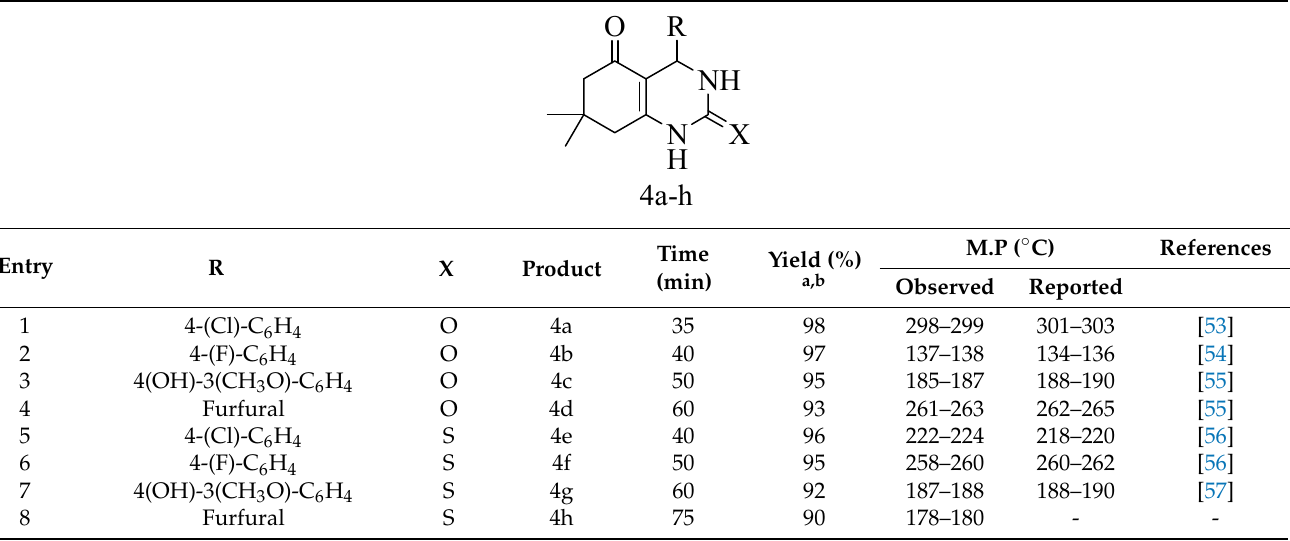
Table 6. The results obtained when using a 50% Al 2 O 3 catalyst for the synthesis of different octahy- droquinazolinone derivatives under solar heat.